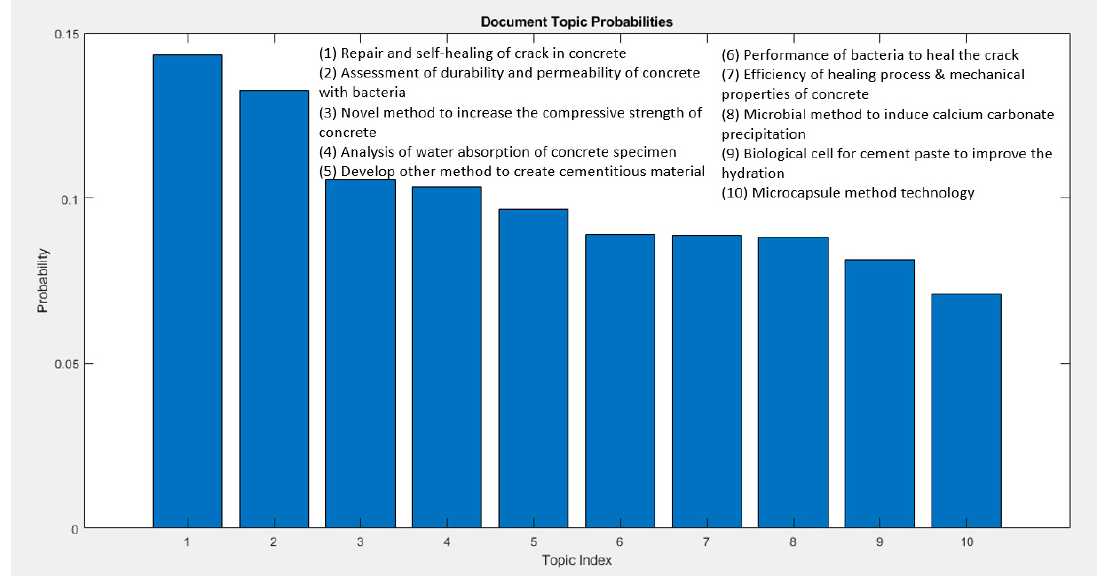
Figure 4. Document topic probabilities of topics 1 to 10.